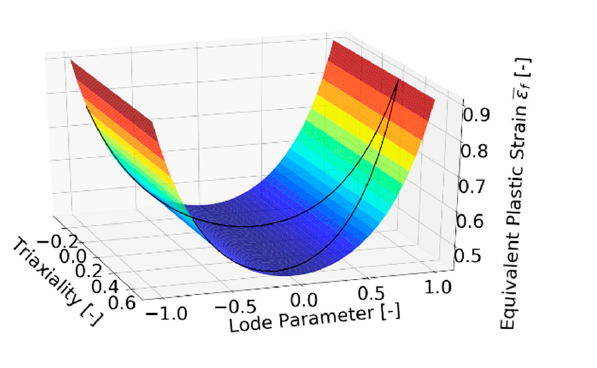
Table 5. Calibrated parameters of Swift and MMC